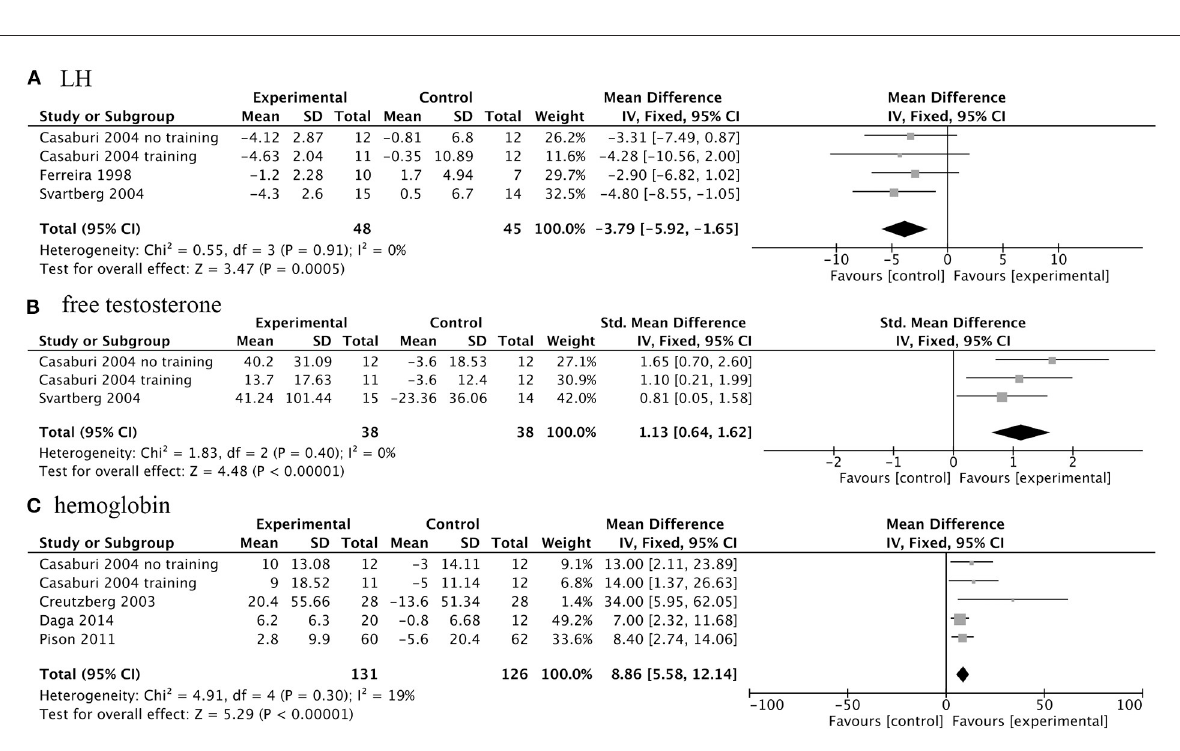
patients gain total weight (9). Under a combination treatment of exogenous androgens and nutrition supplementation, the weight gain of COPD patients is mainly FFM, which will benefit patients even more.